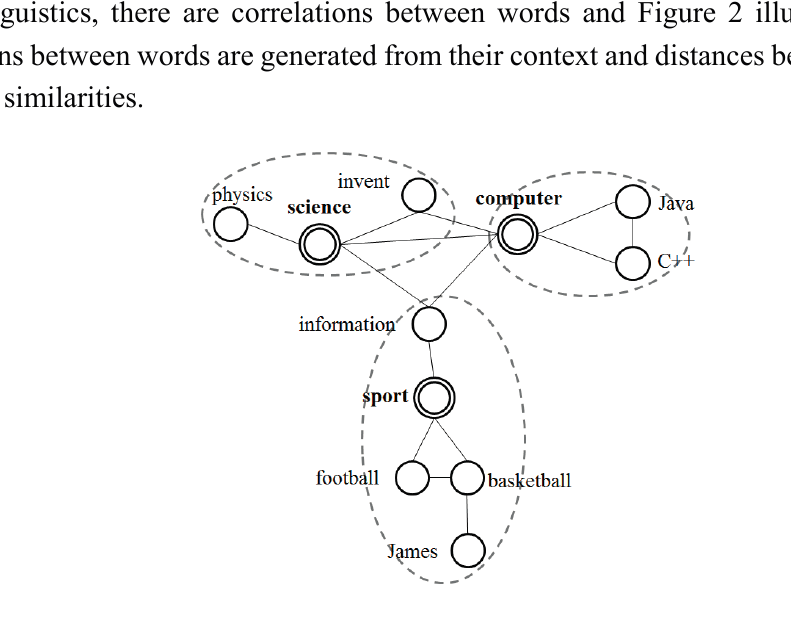
Figure 2. Vector space. For Event Model, we do not deny the existence of topics, but they are only some specific words, such as science, computer and sport in the figure. People perceive topics by semantic association. We use a same way to deal with topics and other